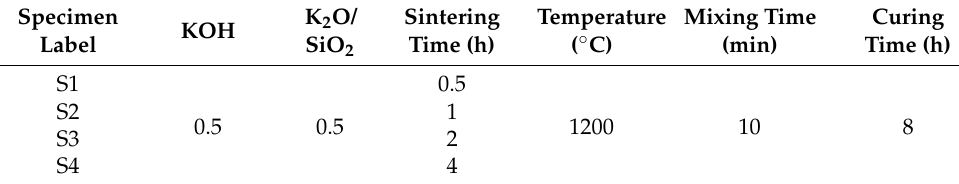
Table 3. Mixing proportion at different sintering times.